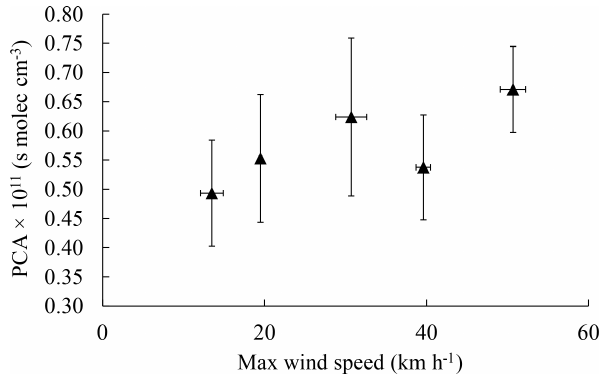
Figure 9. The PCA of 2-methyl-4-nitrophenol as a function of the maximum wind speed during sampling (Environment Canada, His- torical Data, Toronto North York site). Points were sorted in order of increasing wind speed and each point is an average of 10 filter samples; the samples collected while there was precipitation were excluded. Error bars are the errors of the